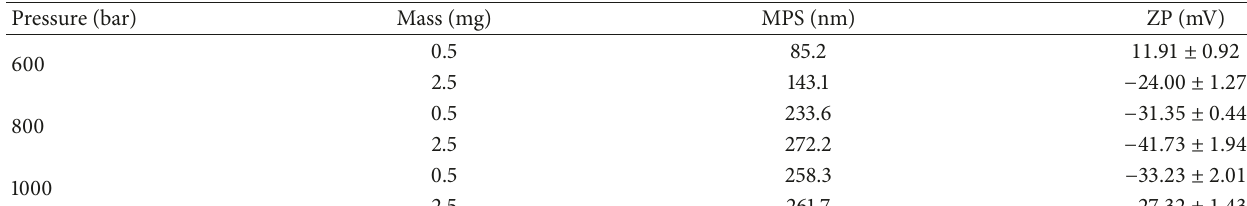
Table 3: Preparation of HCPTNPs with lecithin by HPH.